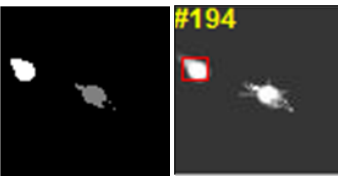
Figure 21. Failure case of tracking results. ( left ) clustering result and ( right ) corresponding tracking